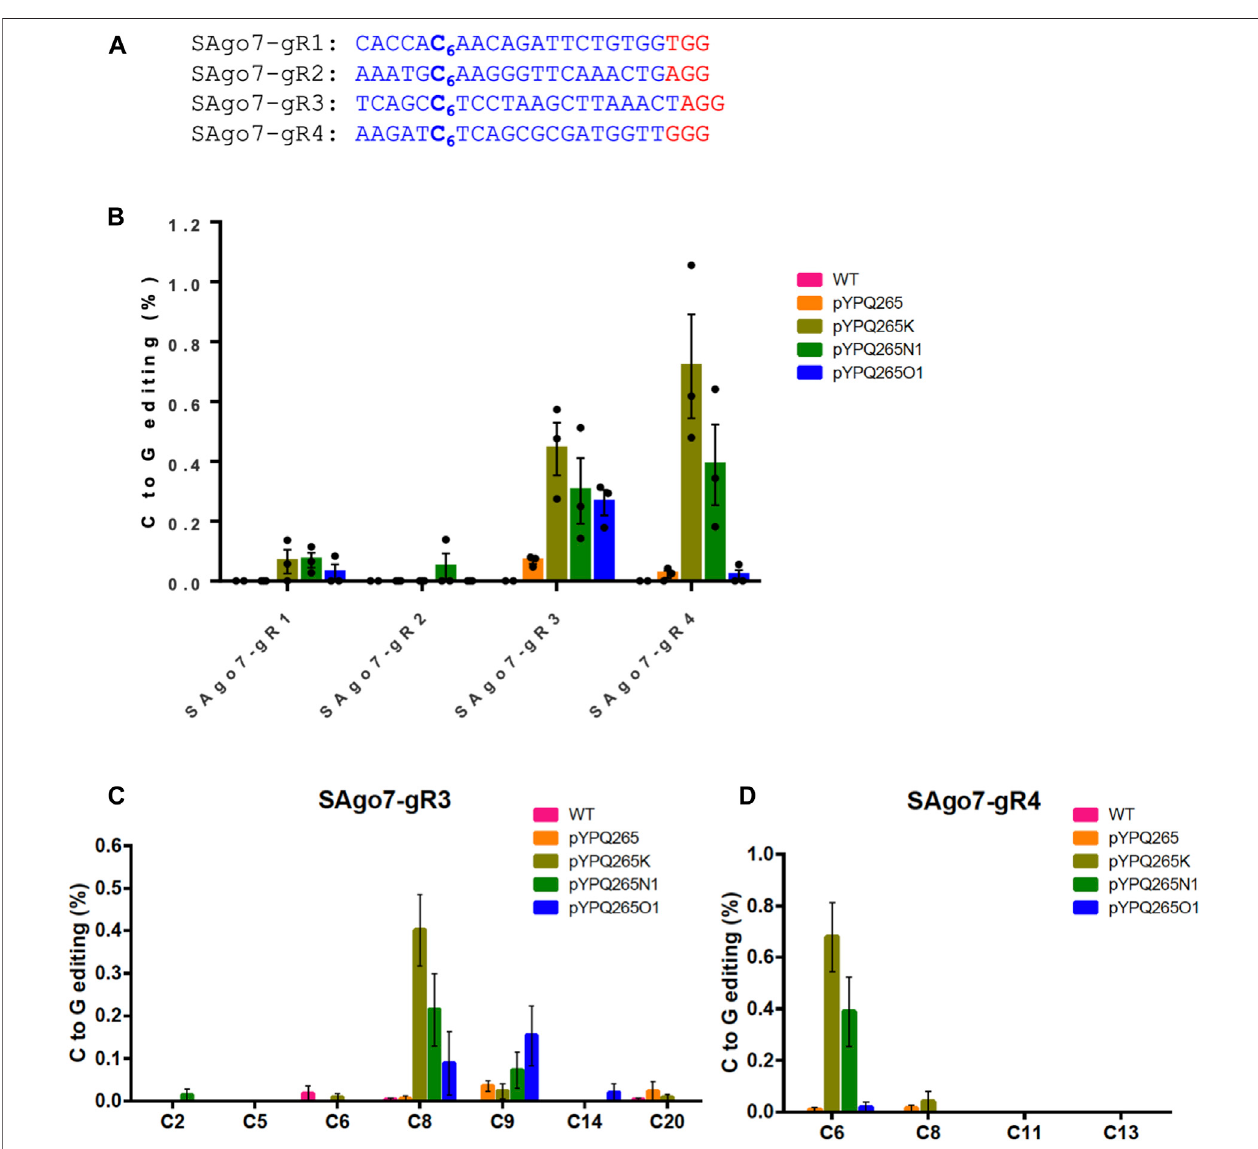
FIGURE 2 | Assessment of BE3 and three CGBEs in tomato protoplasts (A) Four target sites in the tomato genome. The PAM sequences are underlined and highlightedinred. (B) NGSquanti fi cationofC-to-Geditingbyfourbaseeditorsintomatoprotoplasts. FortheWTsamples,waterwasusedinprotoplasttransformation. (C, D) NGS analysisofeditingwindows bydifferentbaseeditorsat SAgo7-gR3 and SAgo7-gR4 target sites. Theerror bars represent standarderrors ofthreebiological replicates.